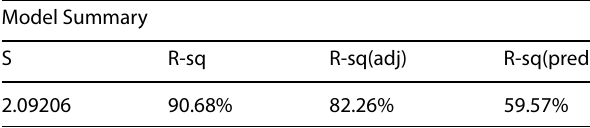
Table 12 Results of model fitting on the second interval Model Summary